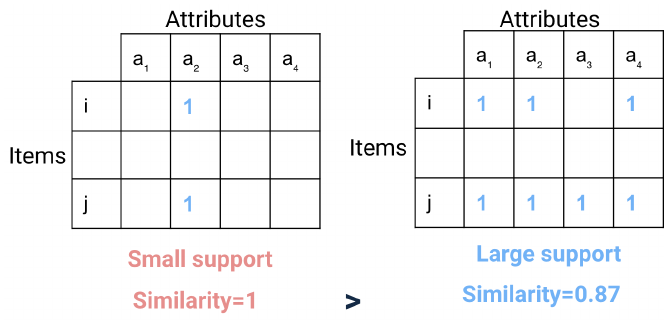
Figure 6. Scenario case for cosinus similarity